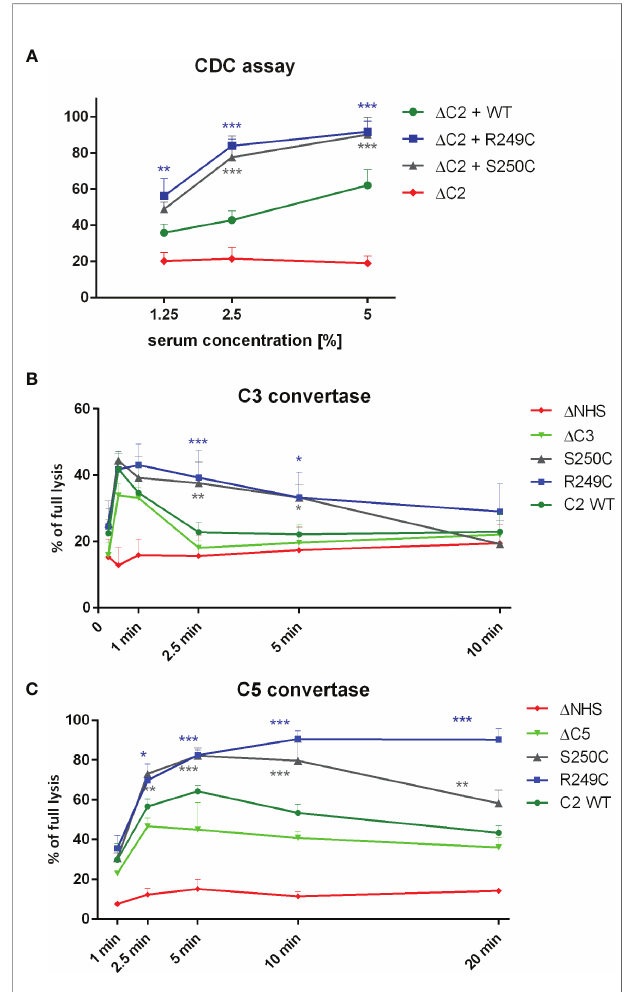
FIGURE 1 | Functional assays of C2 variants. (A) CDC assay. Calcein-loaded Raji cells sensitized with anti-CD20 mAb (ofatumumab) were suspended in C2-depleted serum ( D C2) supplemented with physiological concentration of C2 protein. Cells were incubated for 30 min at 37°C. Supernatant was collected, and fl uorescence of released calcein was measured. The readout obtained for cells lysed with 30% DMSO was considered as full lysis, and the readout obtained for cells incubated with D C2 serum alone indicated background lysis (negative control). (B, C) Convertase activity assays for classical C3 convertase (B) and classical C5 convertase (C) were performed on calcein-loaded Ramos cells suspended in 15% of C3-depleted serum ( D C3) (B) or C5-depleted serum ( D C5) (C) supplemented with physiological concentration of C2 variants. After indicated time period, cells were washed with EDTA-containing buffer to disable further convertase formation and then suspended in 5% guinea pig serum diluted in the same EDTA buffer. The readout was performed as in CDC assay, but heat-inactivated serum ( D NHS) instead of D C2 served as a negative control. Data are collected from at least three experiments. Symbols *, **, and *** denote statistically signi fi cant differences vs. WT supplementation, at p levels of 0.05, 0.01, and 0.001 according to Dunn ’ s multiple comparison